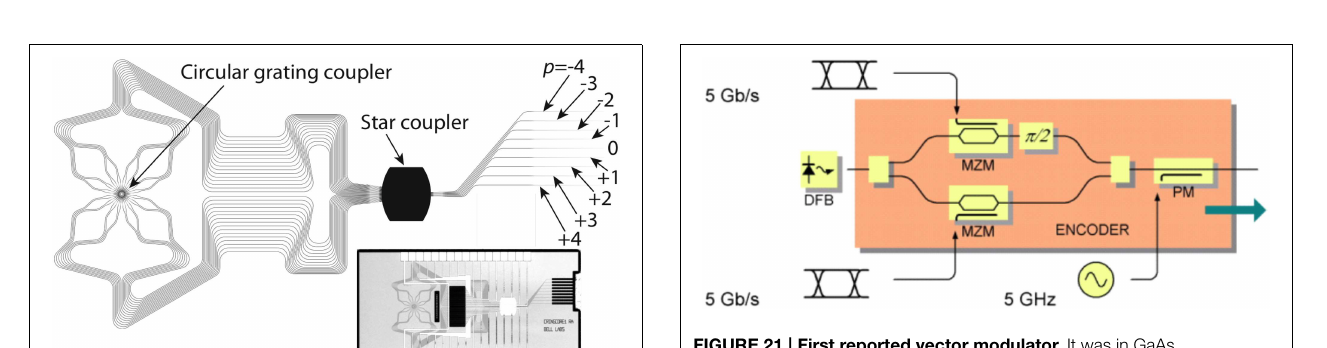
FIGURE 21 | First reported vector modulator. It was in